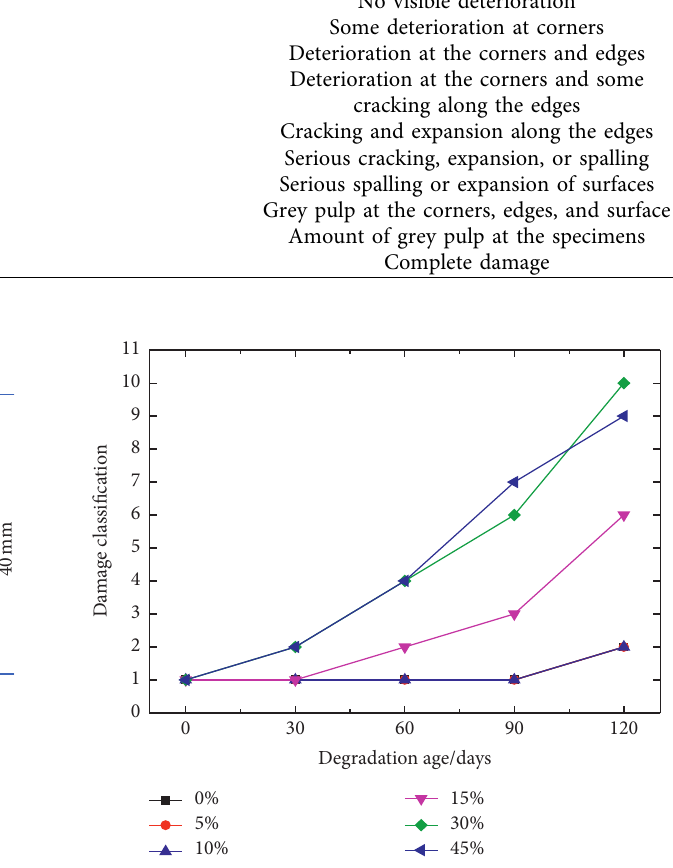
Figure 3: Appearance change grade of different limestone powder contents within 120